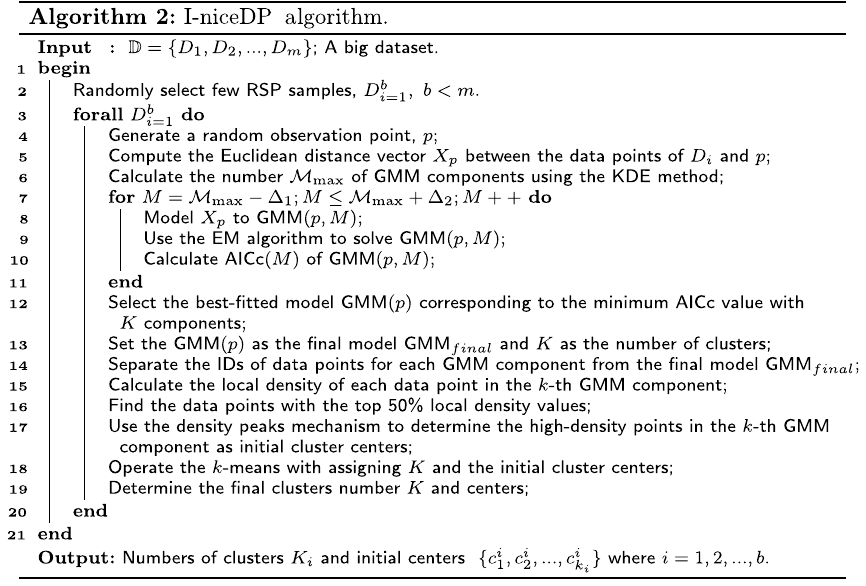
Algorithm for finding the number of clusters in a random